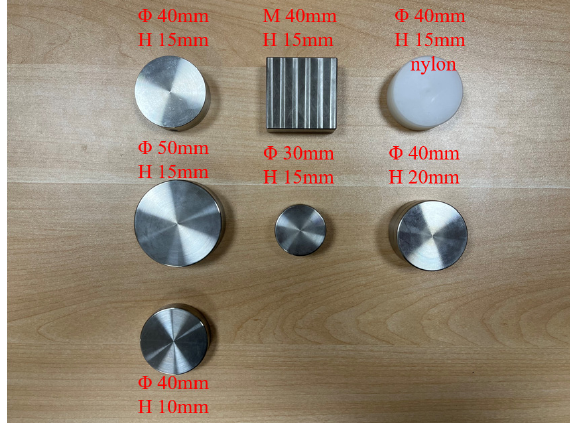
Figure 2. Different sensor packages.